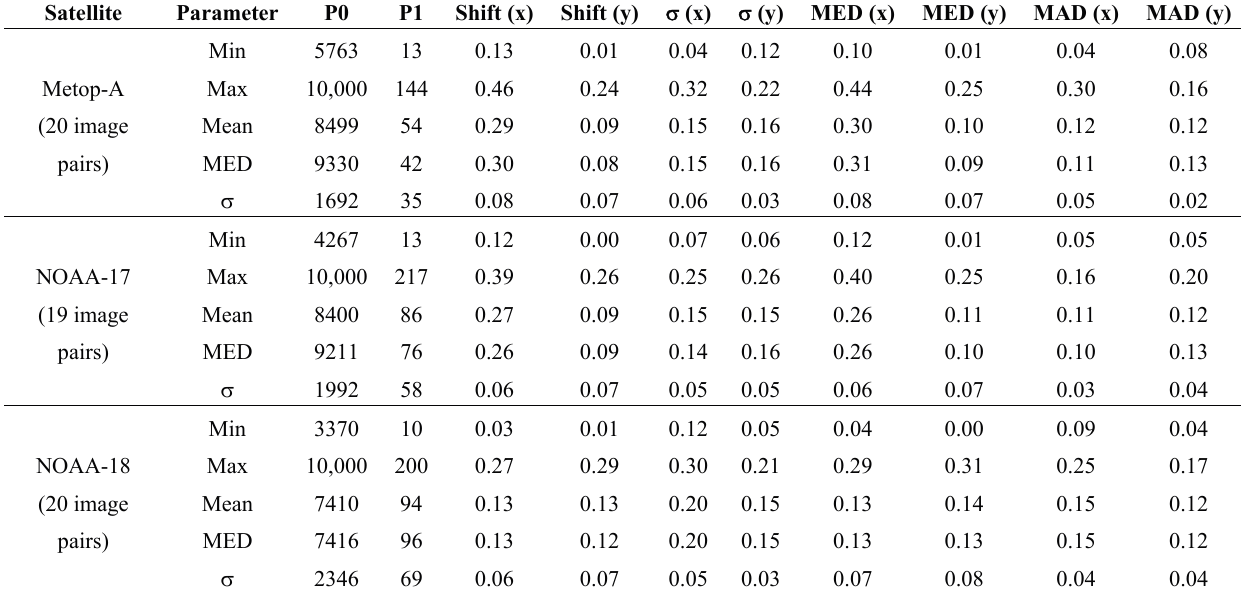
Table 10. BBR accuracy evaluation results between AVHRR Bands 2 and 5; statistical summary from the point matching results of all images for the three satellites. The given statistics are in pixels and are derived from the absolute